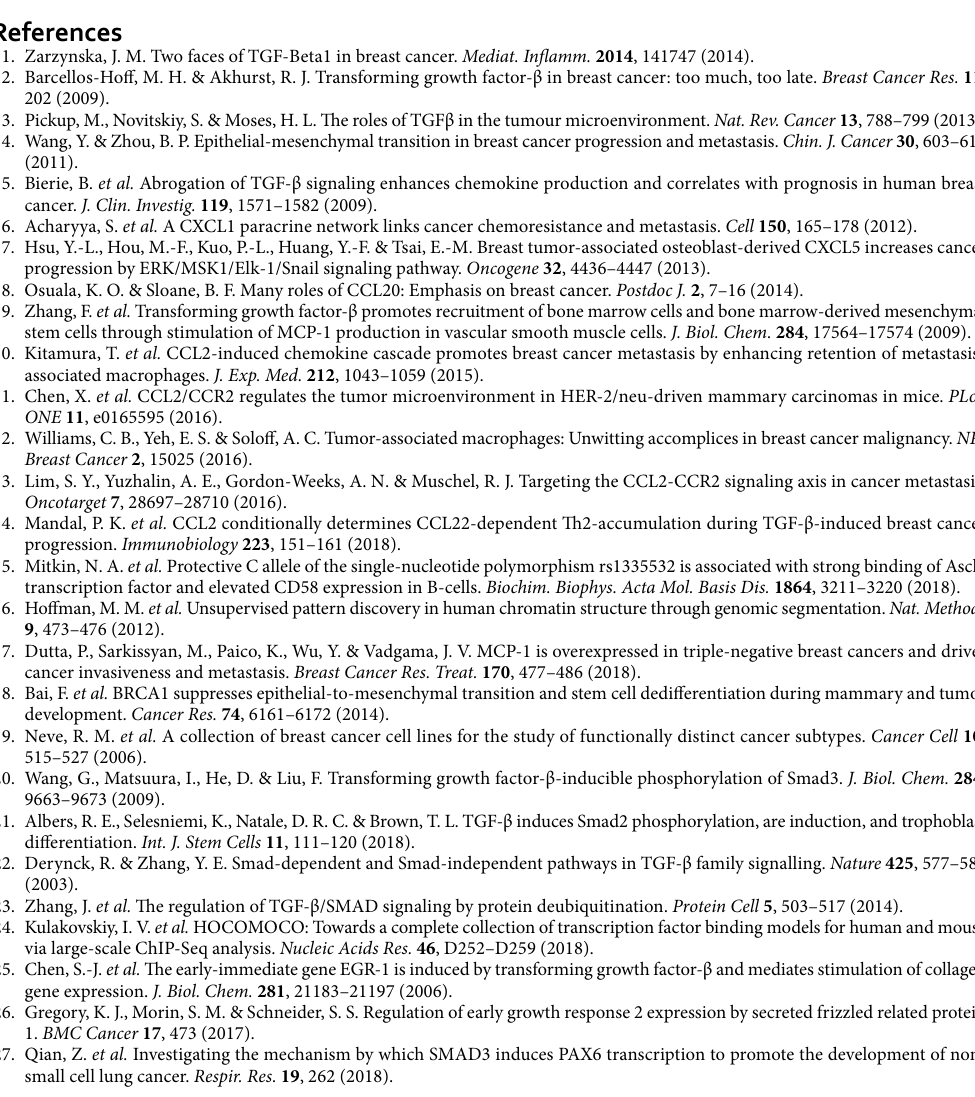
Table S1. None of the control precipitations produced signals above the background level. Pull‑down